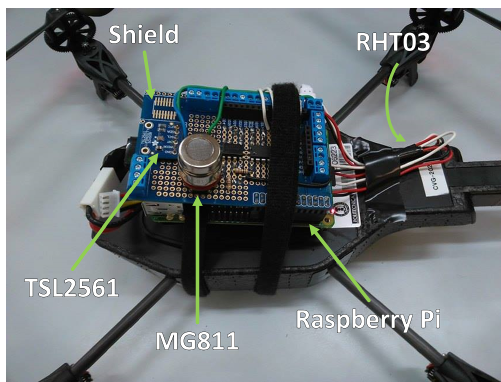
Figure 3. Integration of RHT03 temperature and humidity, TSL2561 luminosity and MG811 carbon dioxide sensors in Parrot AR.Drone 2.0 through Raspberry Pi and